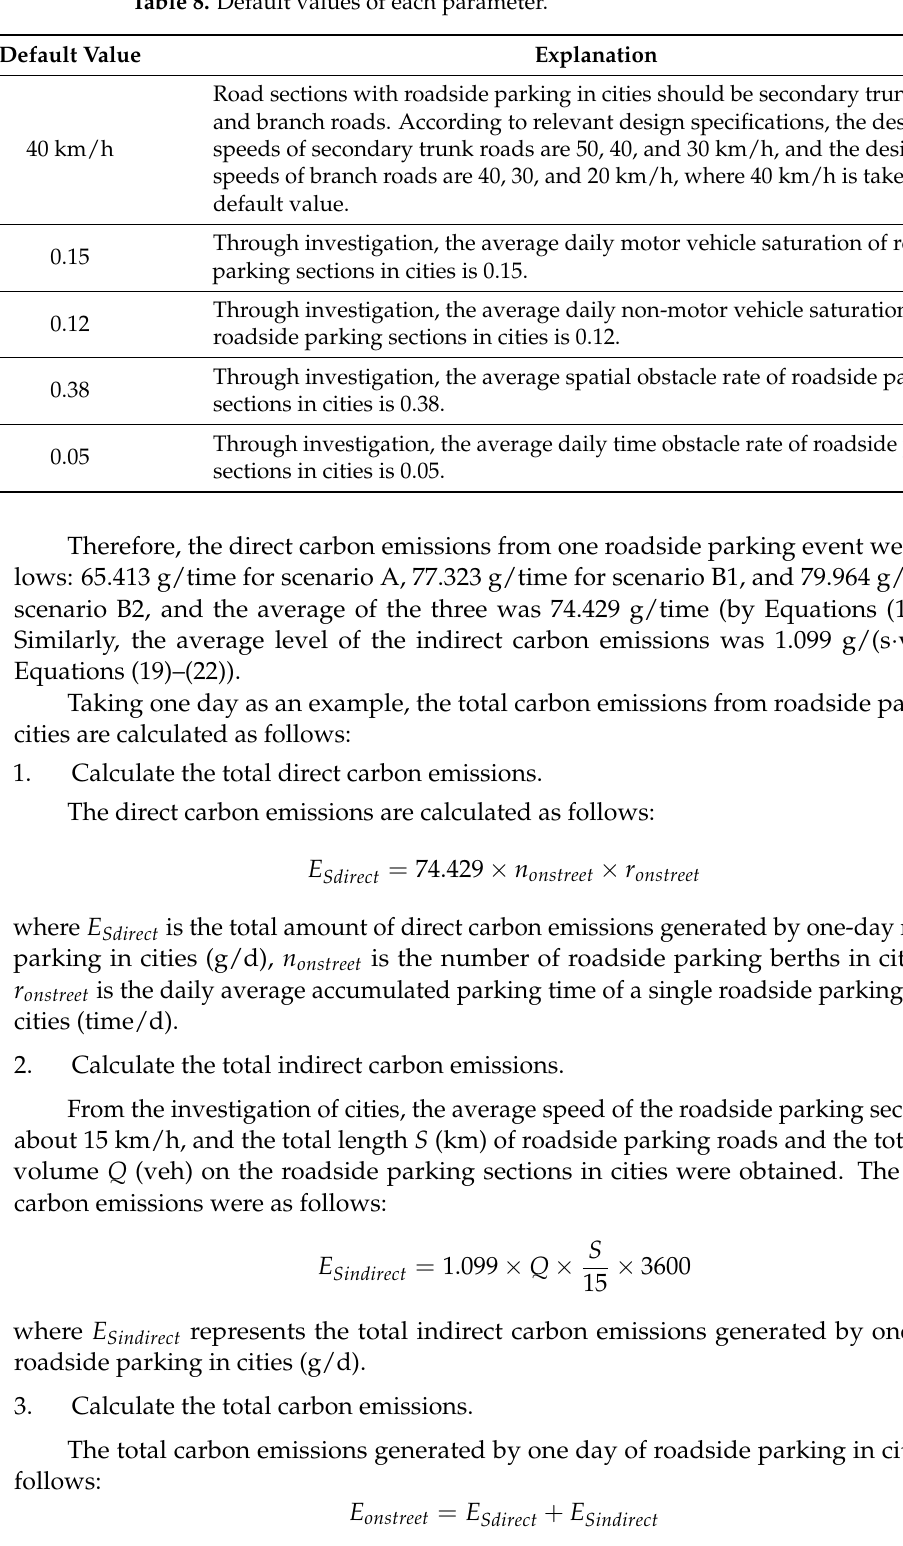
Table 8. Default values of each